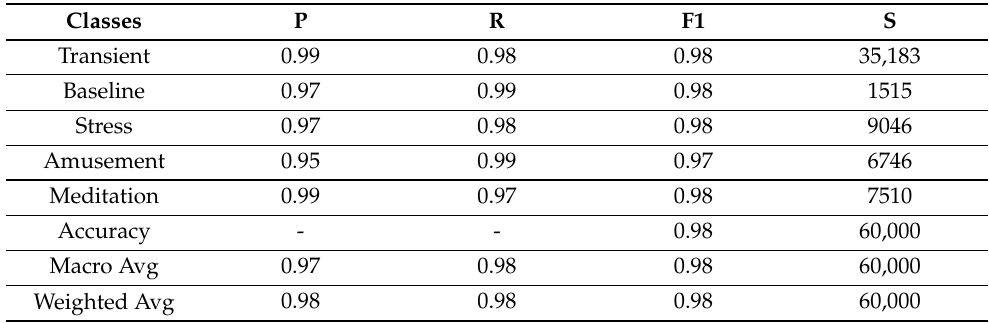
Table 5. Proposed model result of Client 2 for round 2. Key: Precision-P; Recall-R; F1-score-F1;